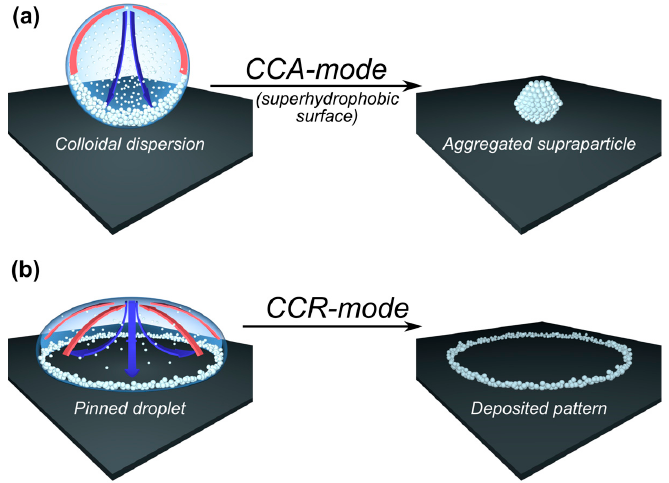
Figure 5. Schematic description of the different modes observed for a drying droplet on a solid substrate, with the mass flow of cooled water (blue arrows) and that due to the interfacial tension gradients (Marangoni flow; red arrows) being indicated for: ( a ) constant contact angle (CCA) mode, as observed on most superhydrophobic surfaces; ( b ) constant contact radius (CCR) mode. The provided mode of wetting directly controls the kinetics of the evaporation process, which